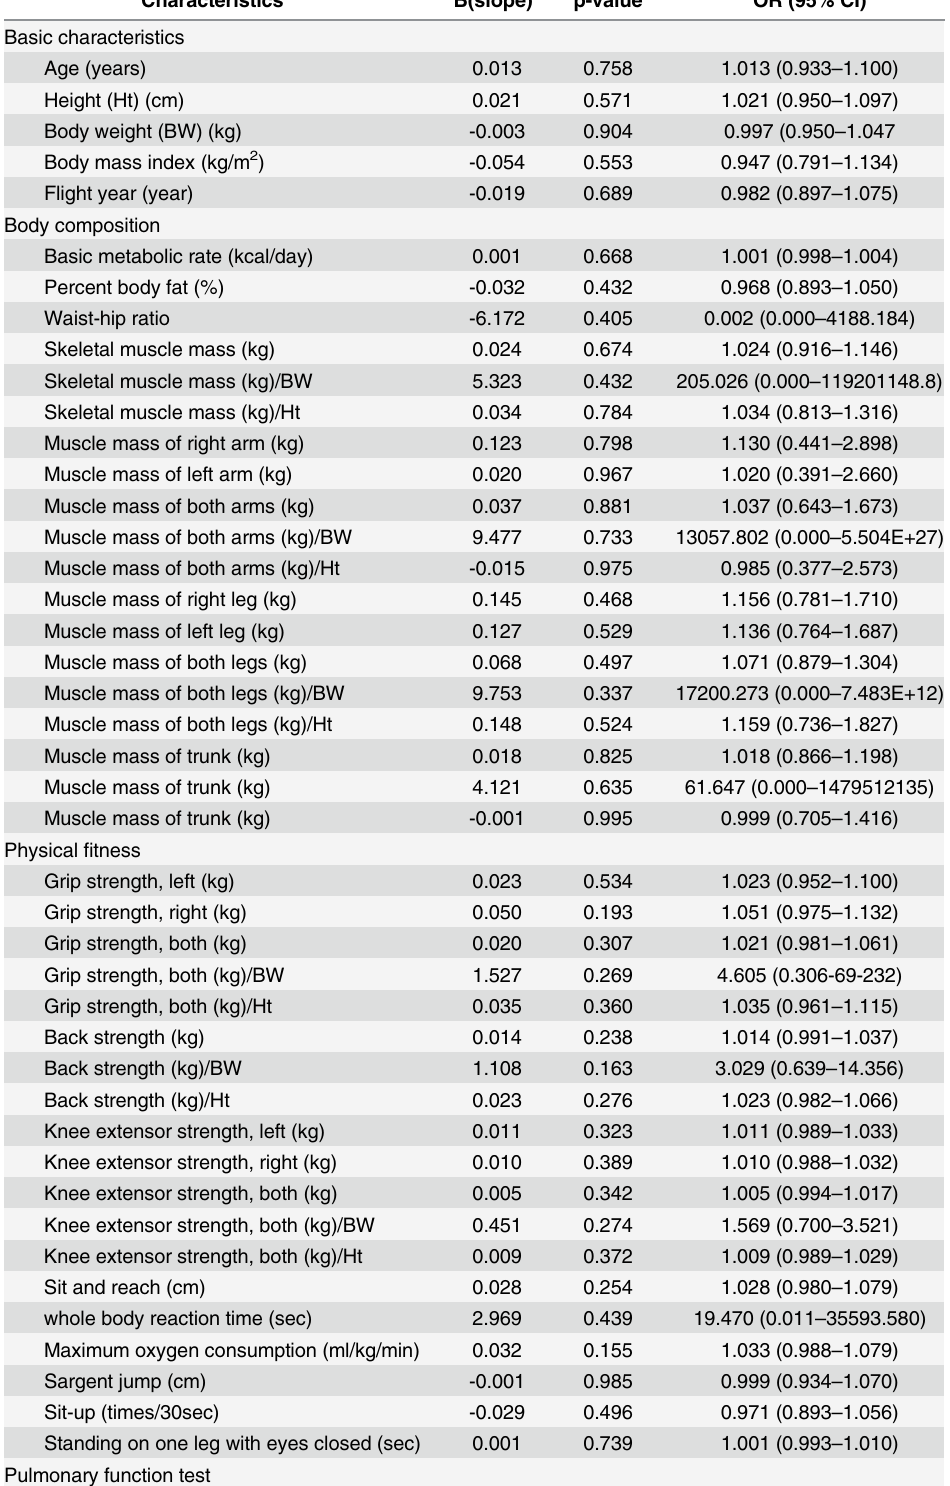
Table 3. Results of binary logistic regression for variables associated with the